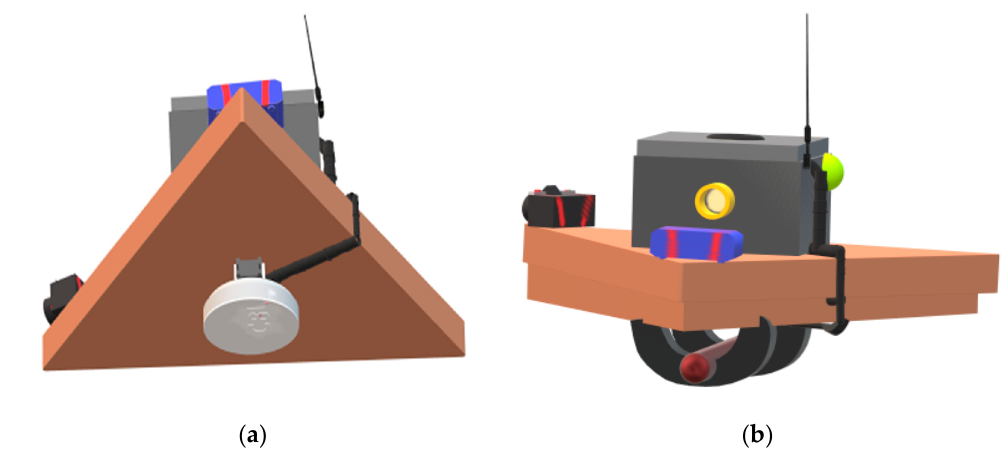
Figure 7. ( a ) S-band antenna, ( b ) Ultra High Frequency (UHF) antenna.